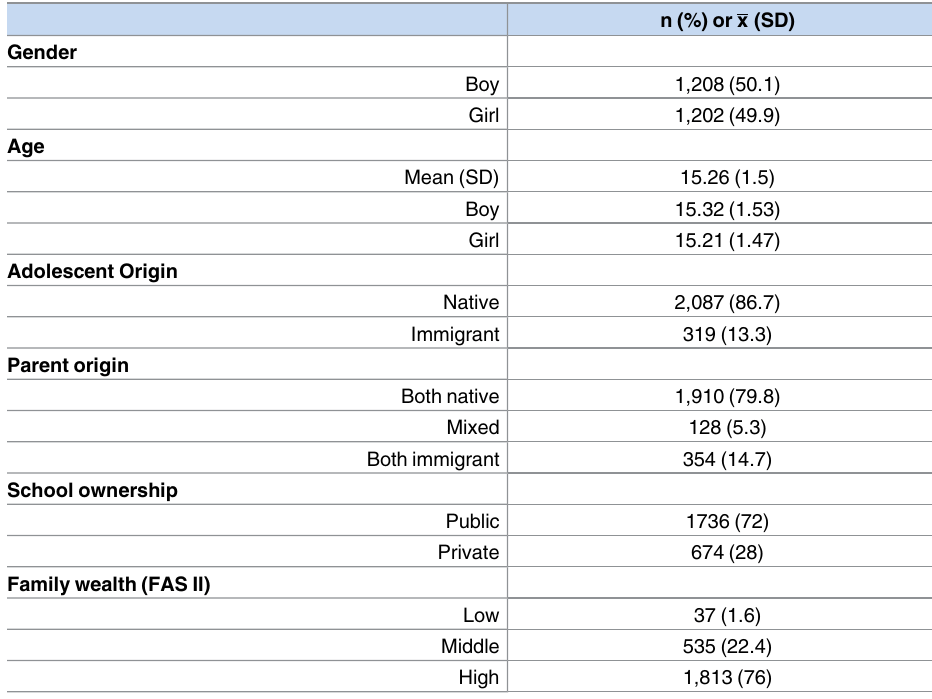
Table 2. Socio-demographic characteristics of the